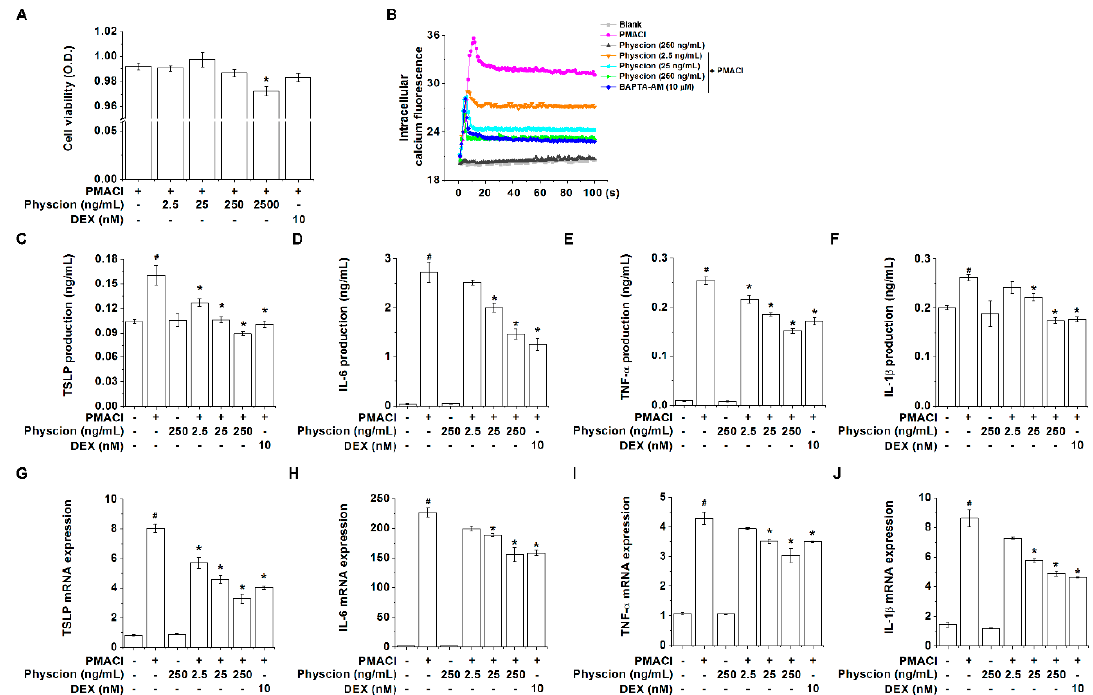
Figure 2. Physcion attenuates thymic stromal lymphopoietin (TSLP) levels in PMA Plus Calcium Ionophore (PMACI)-stimulated HMC-1 cells. ( A ) HMC-1 cells were treated with Physcion or Dexamethasone (DEX) for 1 h and then stimulated with PMACI for 7 h. Cell viabilities were analyzed with a MTT assay. ( B ) Physcion or BAPTA-AM was treated in Fura-2 / AM-pretreated HMC-1 cells for 20 min. The HMC-1 cells were then stimulated with PMACI. Blank, non-stimulated cells; PMACI, PMACI-stimulated cells. HMC-1 cells were treated with Physcion or DEX for 1 h and then stimulated with PMACI for 7 h for ELISA or 5 h for polymerase chain reaction (PCR). The production levels of ( C ) TSLP, ( D ) IL-6, ( E ) TNF- α , and ( F ) IL-1 β were detected by ELISA. The mRNA expression levels of ( G ) TSLP, ( H ) IL-6, ( I ) TNF- α , and ( J ) IL-1 β were detected by Quantitative real-time PCR. Glyceraldehyde-3-phosphate dehydrogenase (GAPDH) mRNA expression levels were analyzed as a housekeeping gene for normalization. Data is expressed as fold induction relative to a vehicle group. # p < 0.05 vs. a non-stimulated group. * p < 0.05 vs. a PMACI-stimulated group.